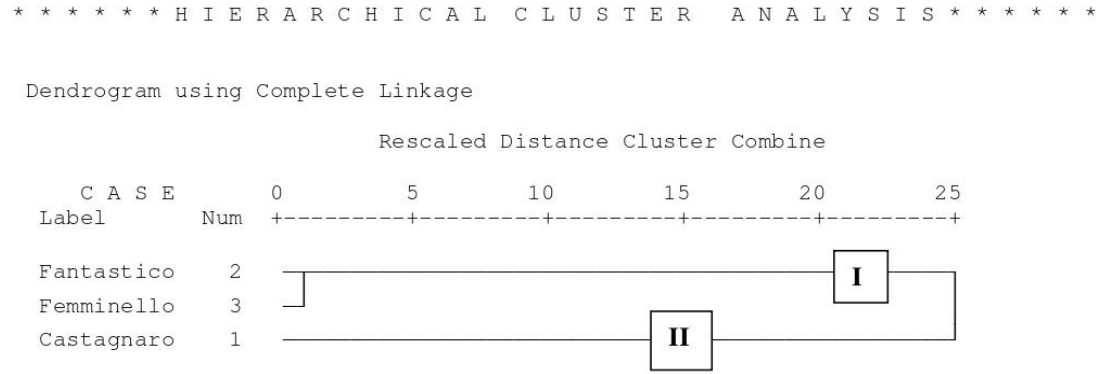
Figure 1. Two-dimensional dendrogram obtained from the cluster analysis of the fruit biometrics and of the physico-chemical properties of juice and cloudy juice of the bergamot fruit ( Citrus bergamia , Risso).